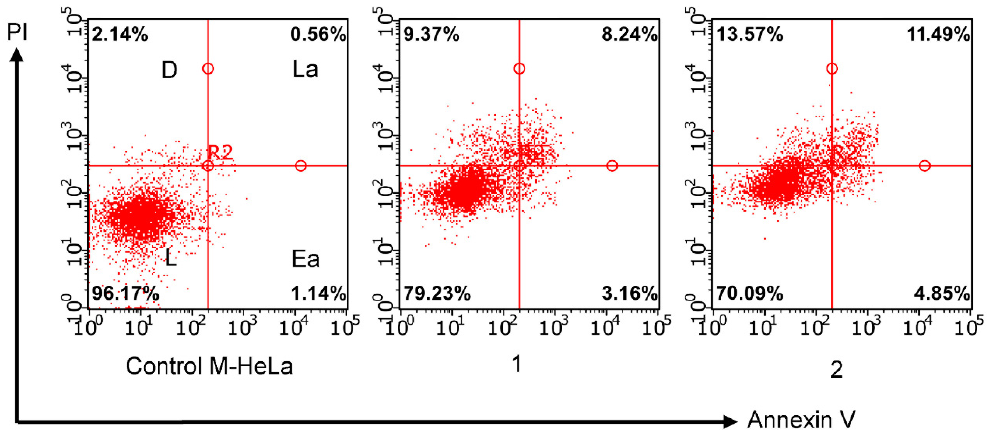
Figure 10. Induction of apoptosis in M-HeLa cells incubated with compound 7 . 1—at concentration IC 50 /2 (6 μ M); 2—at concentration IC 50 (12 μ M); L—living cells; D—dead cells; Ea—early apoptotic cells; La—late apoptotic cells.